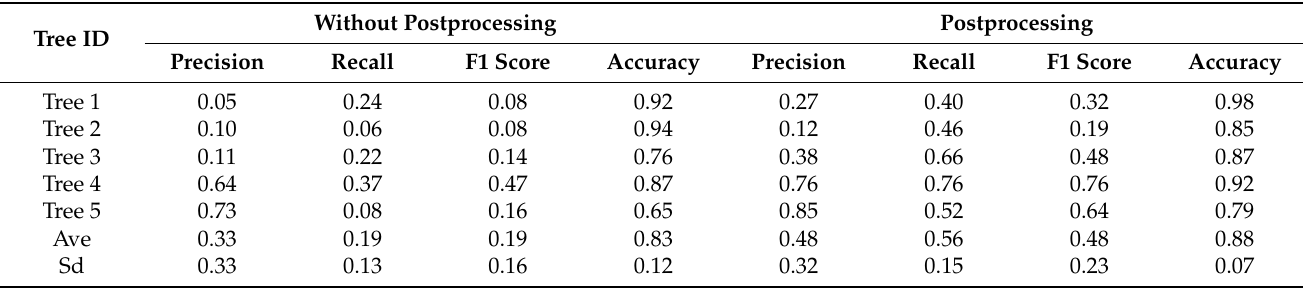
Table 5. The performance of liana and tree classification on our data using